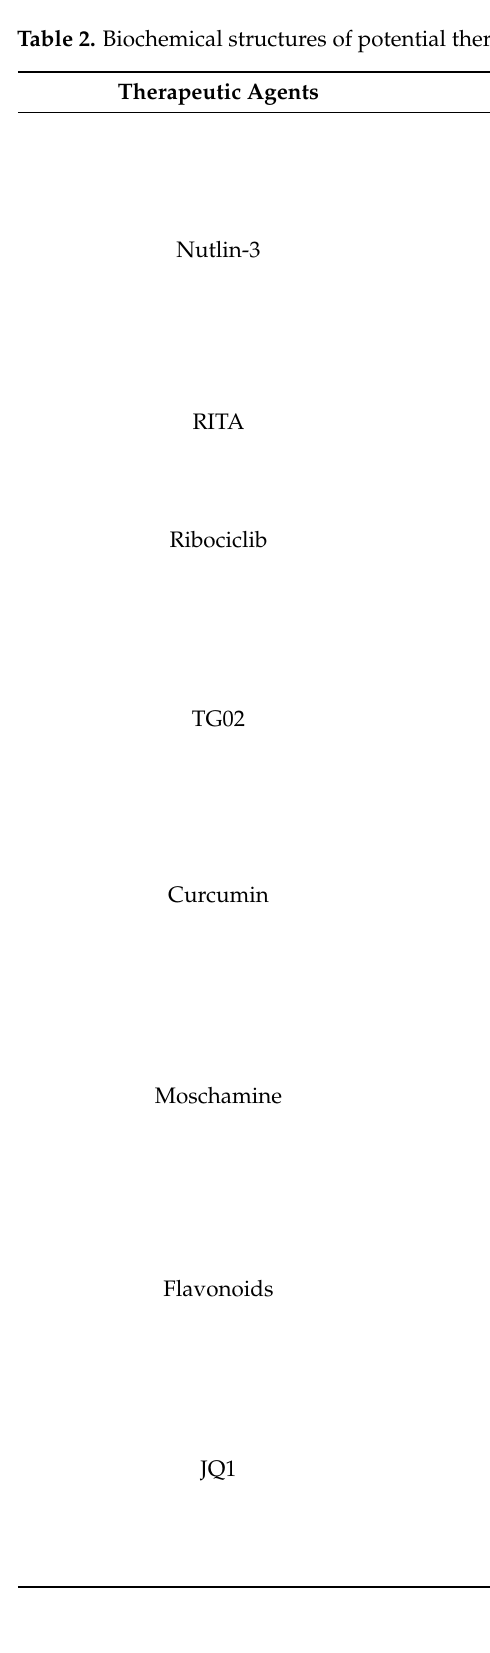
Table 2. Biochemical structures of potential therapeutic agents in